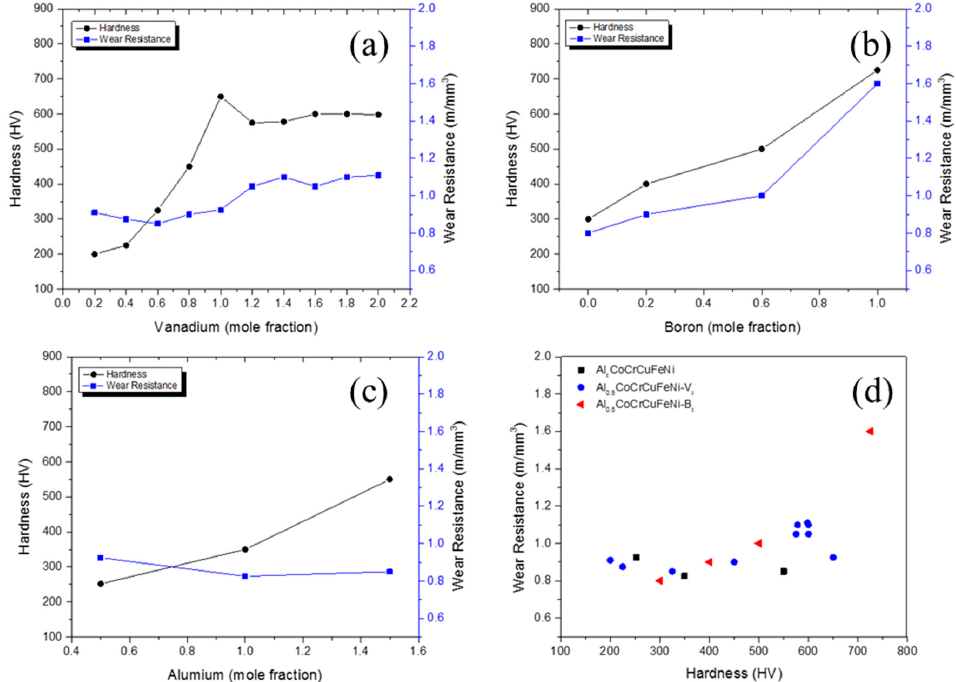
Figure 27. Summary of mechanical, tribological and metallurgical properties of Al 0.5 CoCrCuFeNi- X alloy system. Improved wear resistance of the alloys with increasing proportions of ( a ) Vanadium ( b ) Boron and ( c ) Aluminum; ( d ) relative comparison and summary of wear resistance of Al 0.5 CoCrCuFeNi- X alloys where X is V, B and Al y CoCrCuFeNi where y is 0.3, 1.0 and 1.5 [38,89,90].